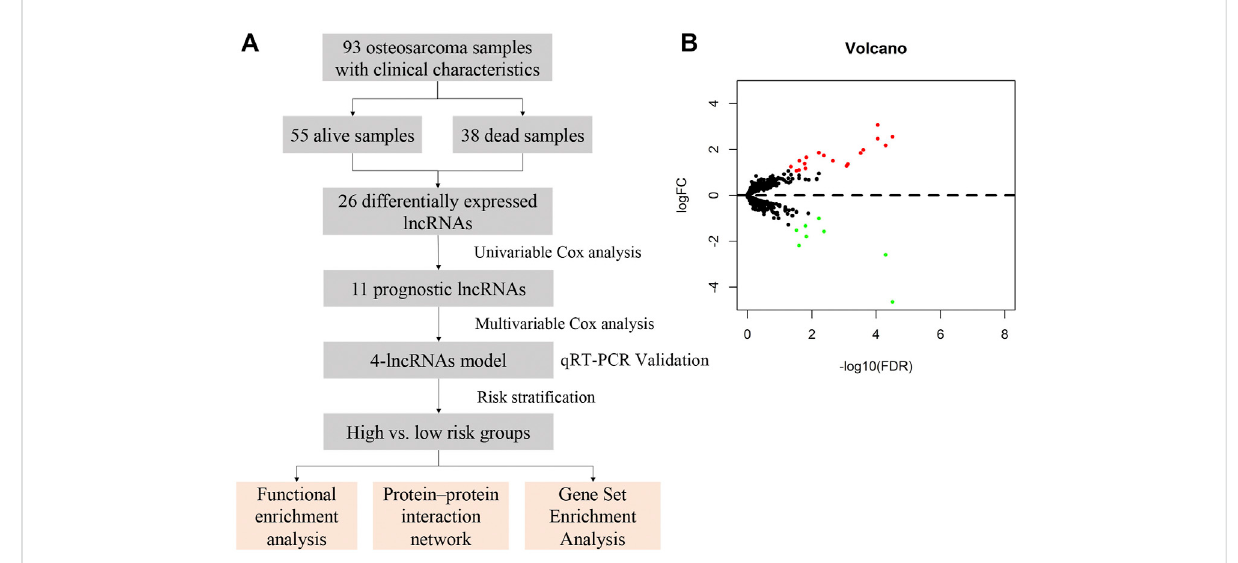
FIGURE 1 Study design and expressionpro fi les of the26 survival-related lncRNAs inosteosarcoma. (A) Work fl ow of thepresentstudy. (B) Volcano plot of differentially expressed lncRNAs in samples from deceased and living patients. Red indicates upregulated lncRNAs in deceased patient samples, and green indicates down-regulated lncRNAs. False discovery rate, FDR < 0.05 and logFC > 1.